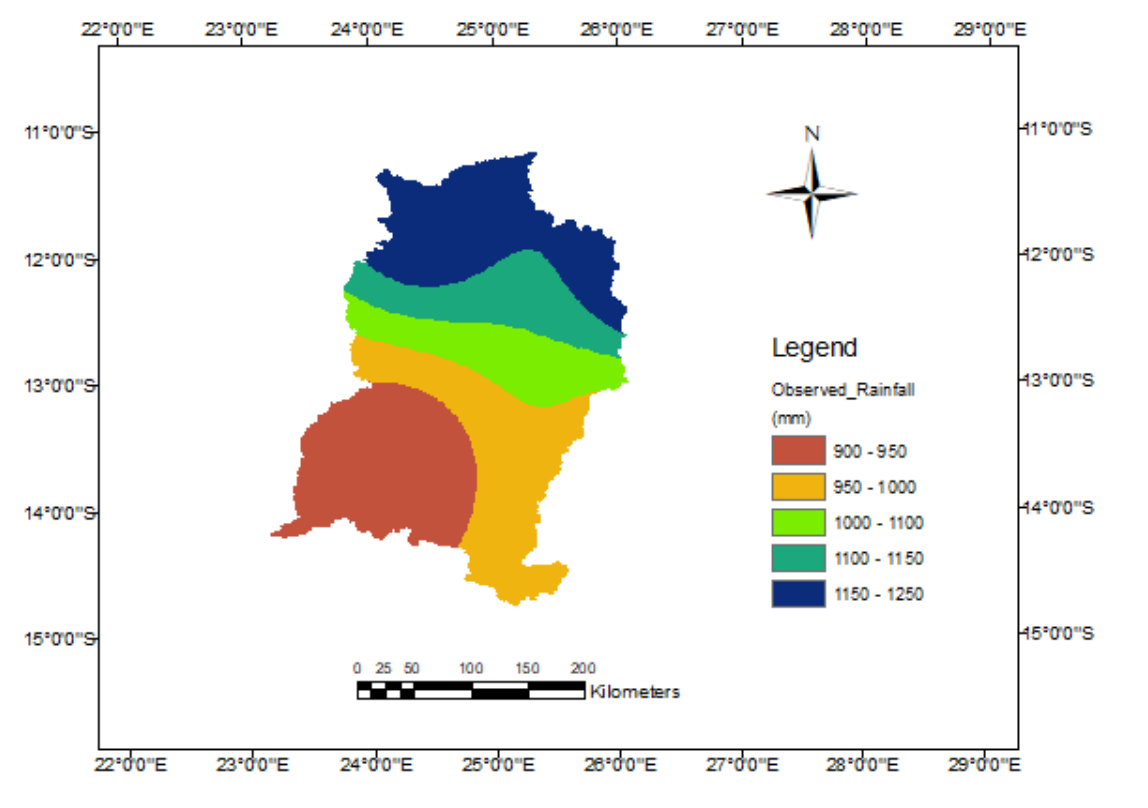
Figure 9. Observed rainfall across the Kabompo catchment.